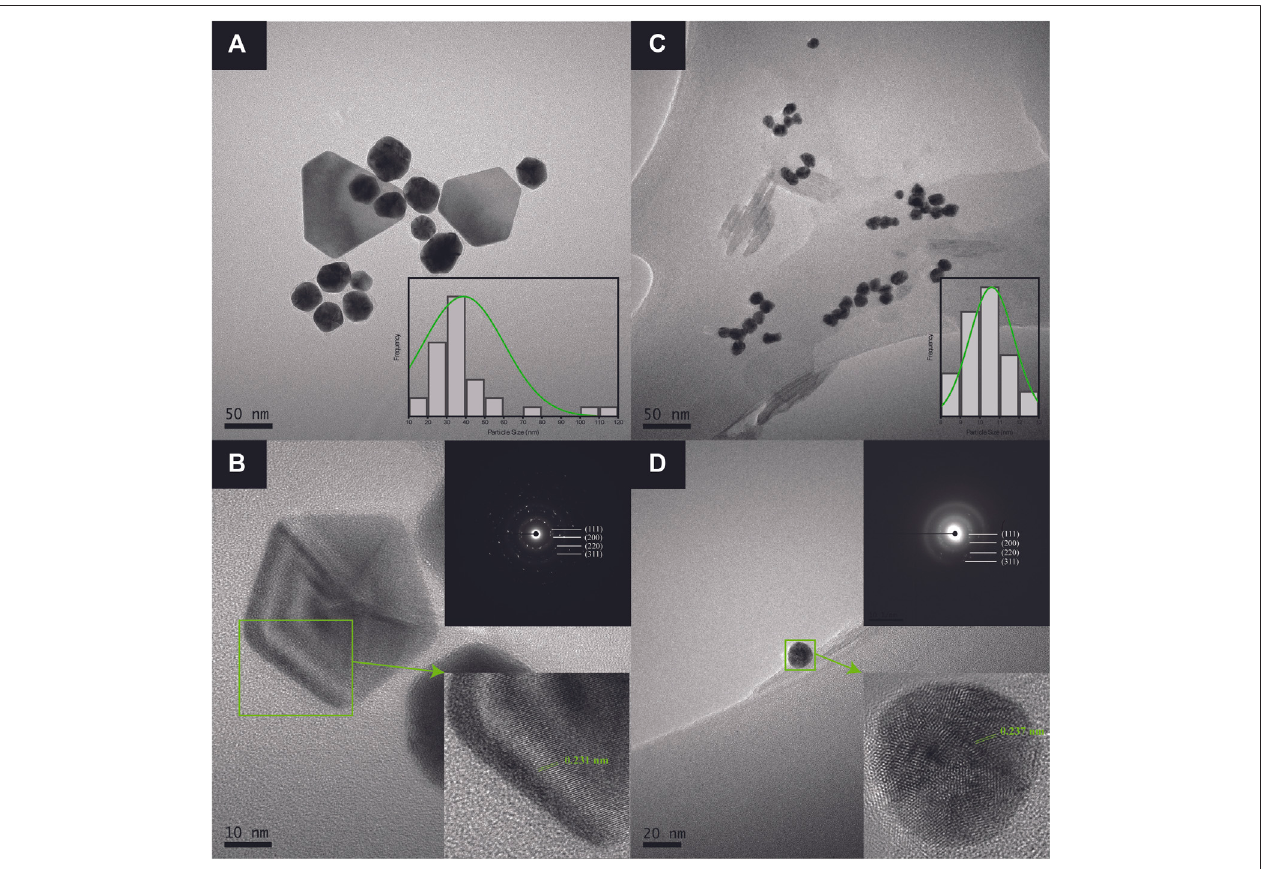
FIGURE 6 | HR-TEM images of (A) anisotropic AuNPs@pH6 with corresponding particle size distribution and (B) a single pentagonal crystal structure with its d-spacing and electron diffraction pattern (C) isotropic AuNPs@pH10 with corresponding particle size distribution and (D) a single spherical crystal structure with its d-spacing and electron diffraction